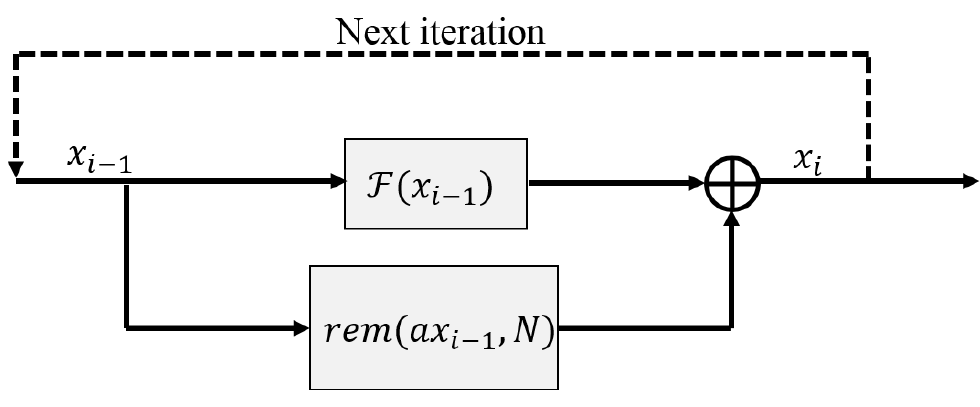
Figure 1. Graphic representation of the chaotification technique